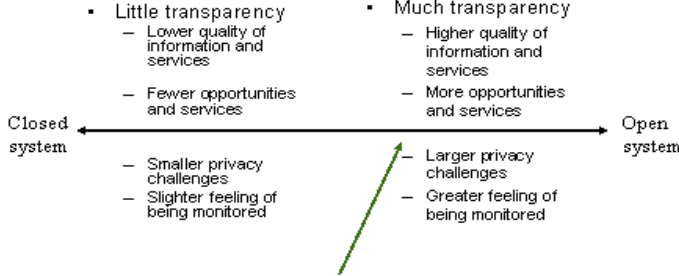
Figure 2. Transparency and privacy